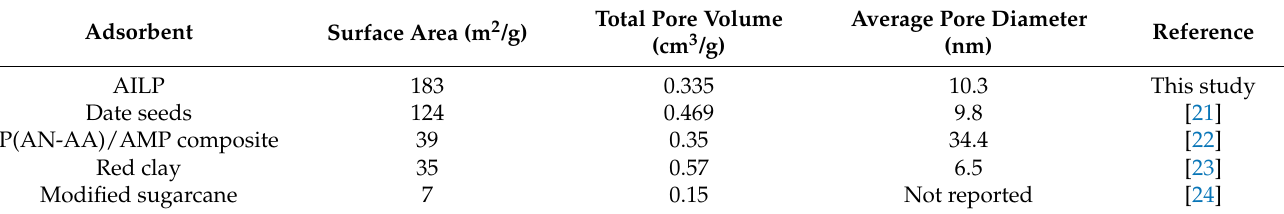
Table 1. The surface area, total pore volume, and average pore diameter for various adsorbents. Total Pore Adsorbent Surface Area (m 2 /g)